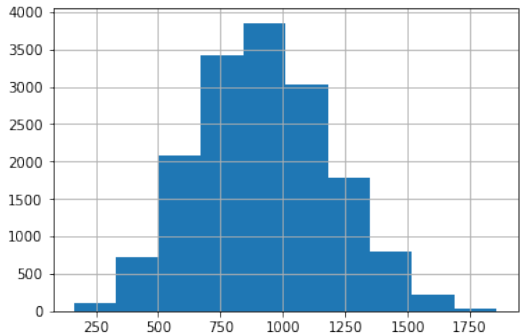
Figure 8. Sleep habit score distribution for all data. Statistical values of sleep characteristics for each sleep state are as follows.